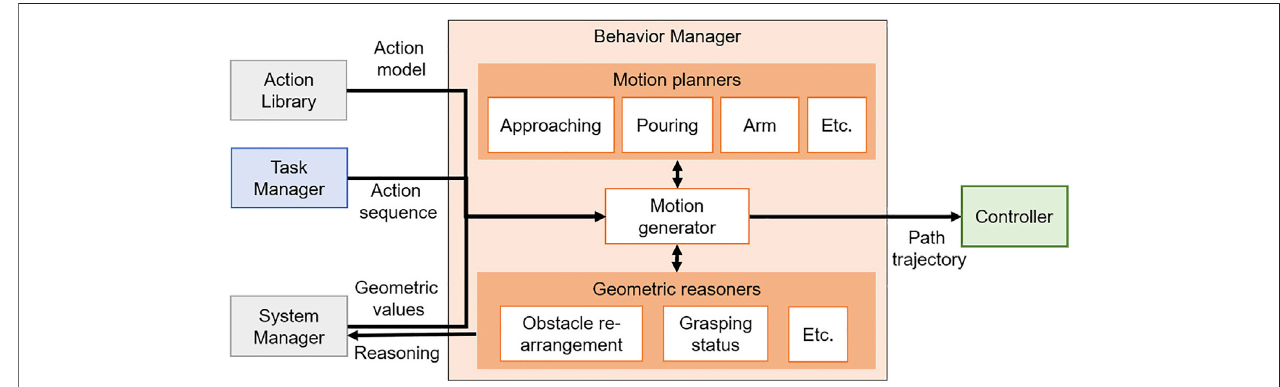
FIGURE 5 | Diagram of the Behavior